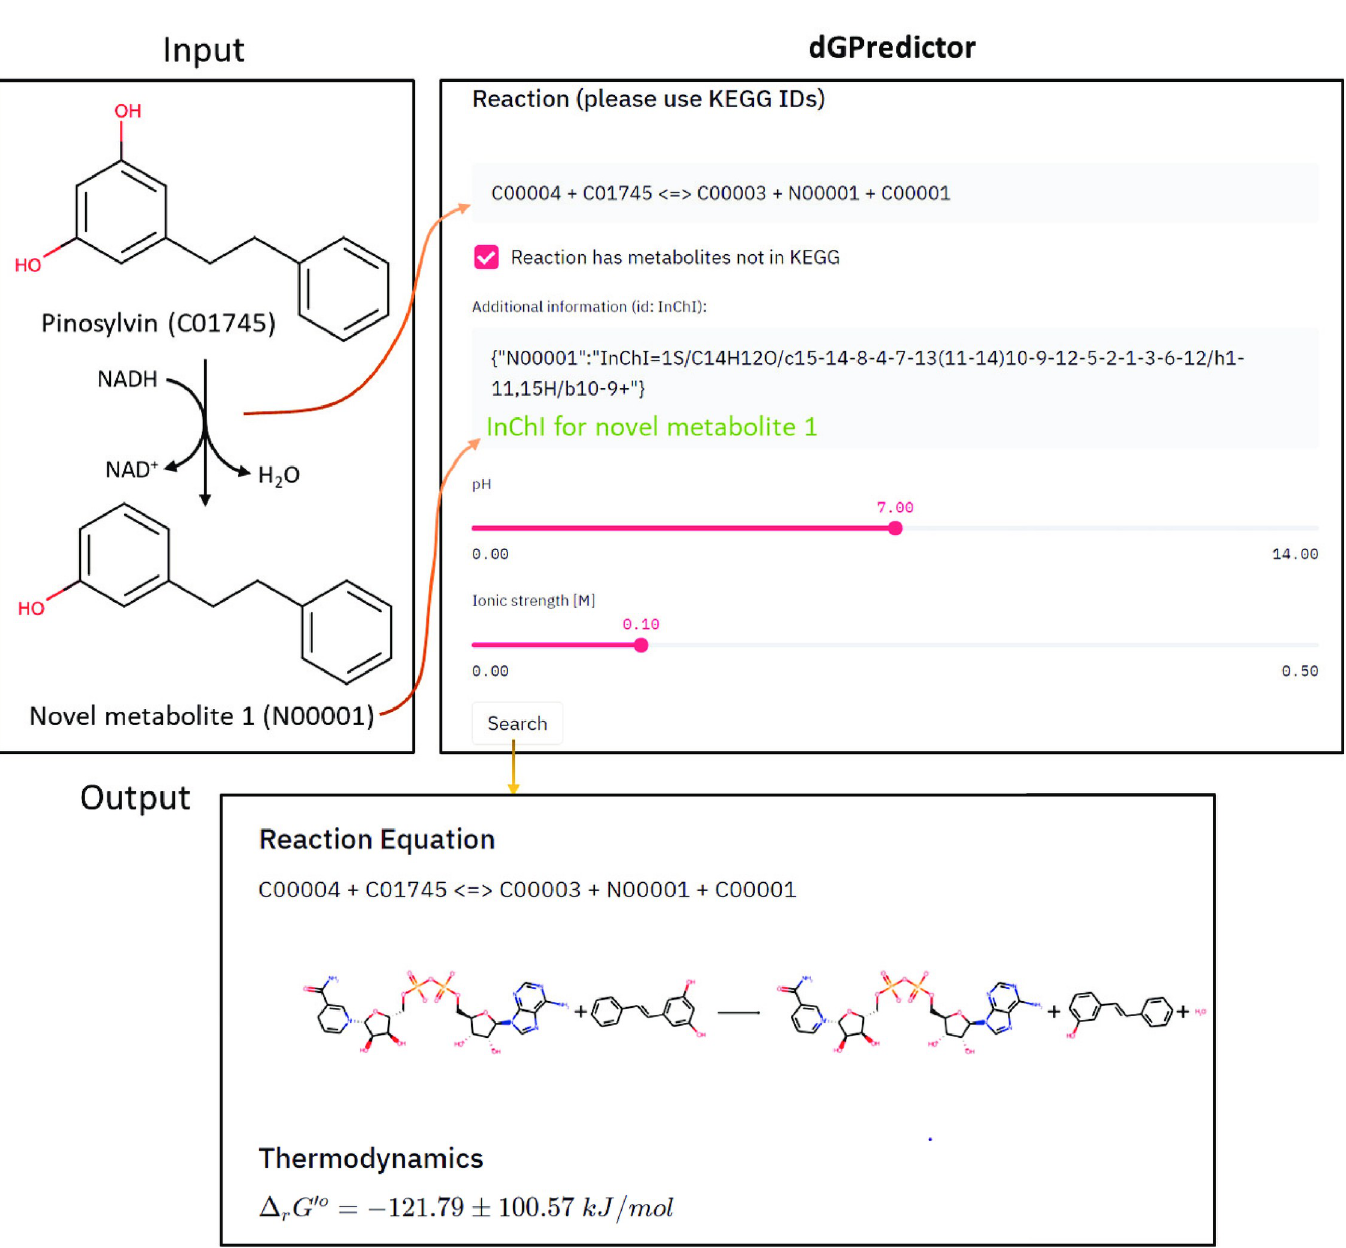
Fig 5. The graphical user interface of dGPredictor. It allows the input of metabolites using their KEGG IDs (for known compounds) and InChI strings (for novel compounds) in a chemical reaction. Intracellular conditions of pH and ionic strength can also be adjusted using sliders. The final output shows the standard transformed Gibbs energy Δ r G 0 o of the reaction at a particular pH and ionic